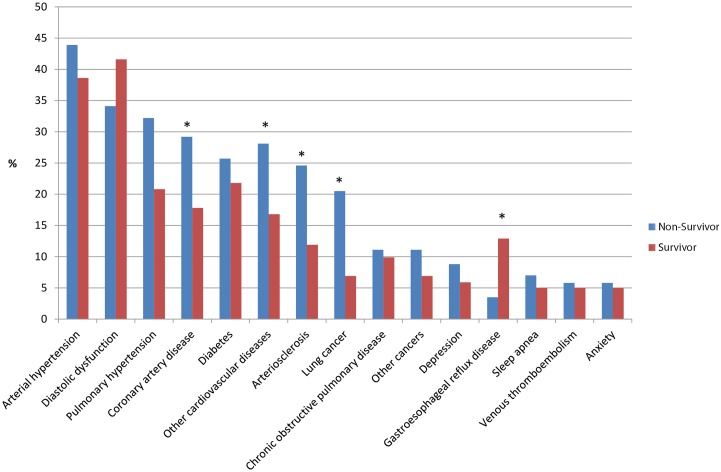
Prevalence of comorbidities in relation to survival status (survivors: red bars, non-survivors: blue bars).The figure also denotes those comorbidities with a significantly (*) different prevalence in non-survivors compared with survivors regardless of their absolute prevalence.